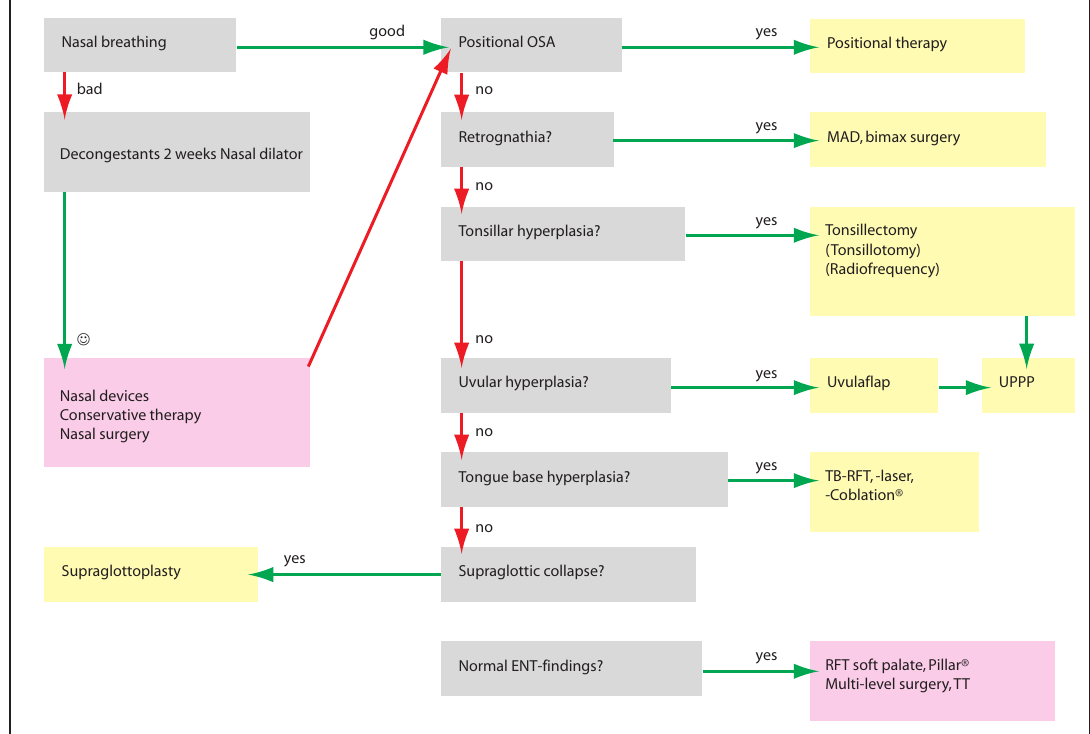
Figure 1 Flow diagram for therapy in OSA patients if CPAP is not accepted. MAD: mandibular advance- ment device; Bimax: maxillo-mandibular advancement;TB-RFT: tongue base radio- frequency treatment; TT: